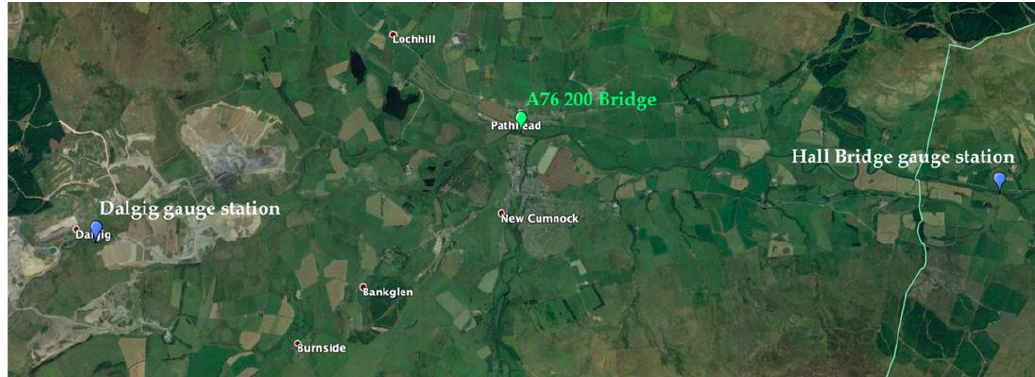
Figure 21. Map of Scottish Environmental Protection Agency (SEPA) gauging station.